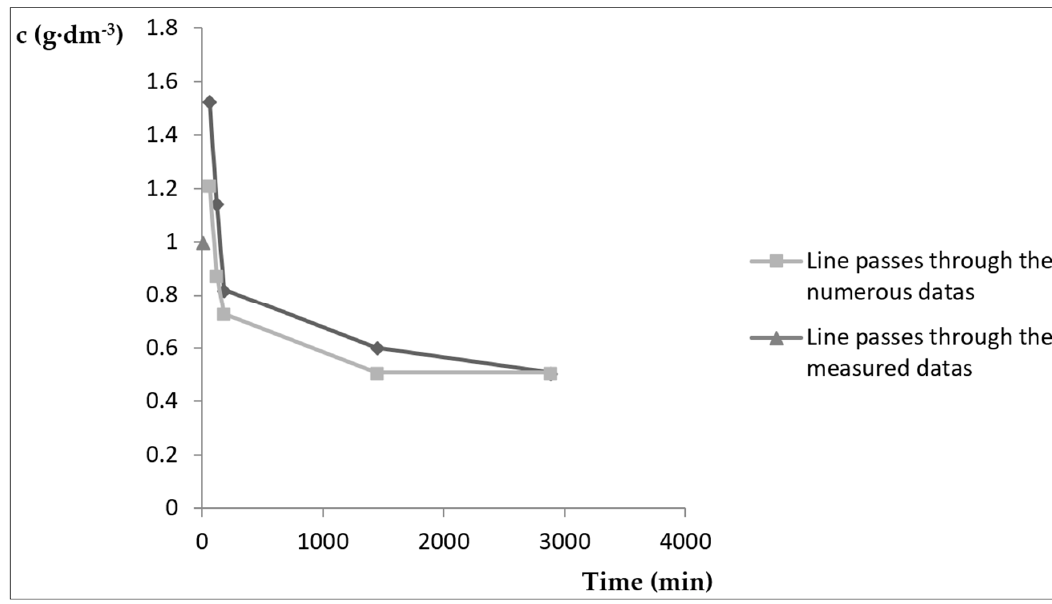
Figure 2. Dependence of the weight concentration c of cupric cations in solution according to time.